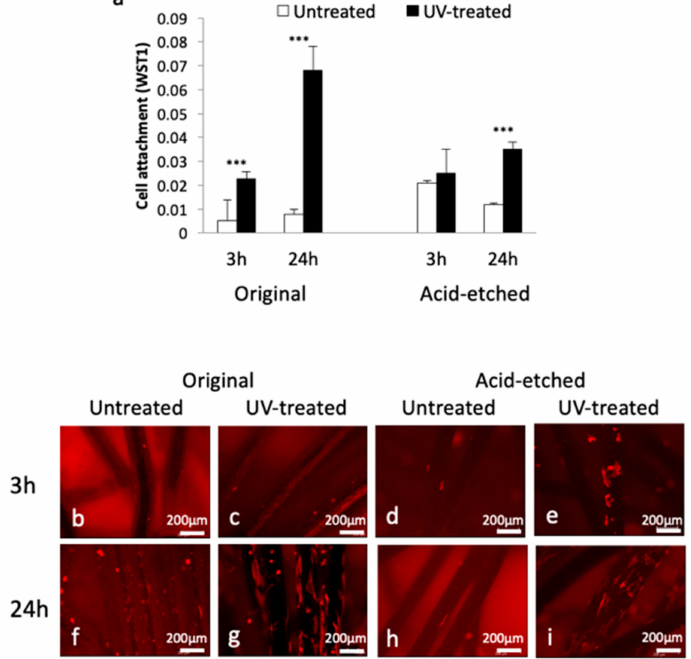
Figure 3. Cell attachment of rat bone marrow-derived osteoblasts on original / acid-etched, and untreated- / UV-treated Ti microfiber sca ff olds. ( a ) The number of cells attached to each sca ff old with or without UV treatment at 3 and 24 h, as evaluated by WST-1 assay. The number of cells in the UV-treated Ti microfiber sca ff olds was significantly greater than that in the untreated Ti fiber sca ff olds except for acid-etched sca ff olds at 3 h. ( b – i ) Microscopic appearance. Small, round shaped cells sparsely attach on the untreated Ti microfibers at 3 h ( b – d ), and on those at 24 h ( f , h ). Relatively many cells attach on the UV-treated acid-etched Ti microfibers ( e ). The shape of osteoblast spreads and the number of cells increases in the UV-treated Ti microfibers at 24 h ( g , i ). Each value represents the mean ± standard deviation of triplicate experiments ( n = 3). *** p <